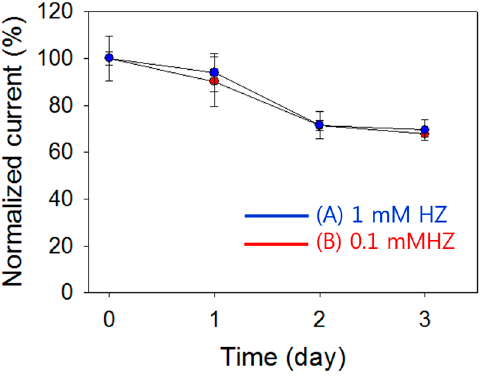
Figure 8. Normalized current (at 0.3 V) for HZ detection according to the time (day). ( A ) 1 mM·HZ and ( B ) 0.1 mM·HZ were detected. The error bars indicate the standard deviations of 4 measurements. and ( B ) 0.1 mM ¨ HZ were detected. The error bars indicate the standard deviations of 4